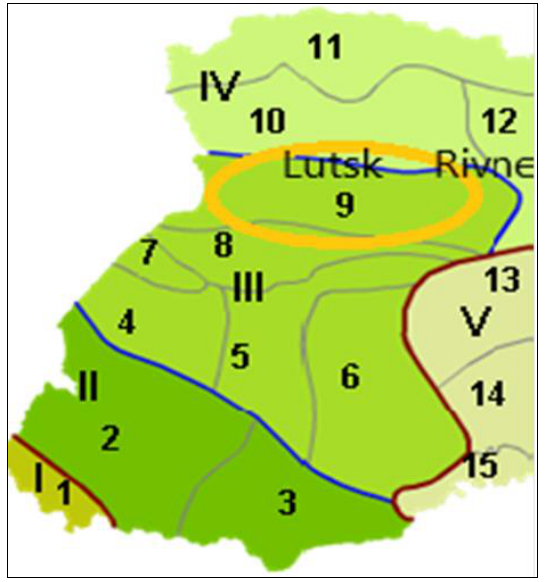
Fig. 1. The research territory (marked by an orange line) on the fragment from the map of the geobotanical zoning of Ukraine